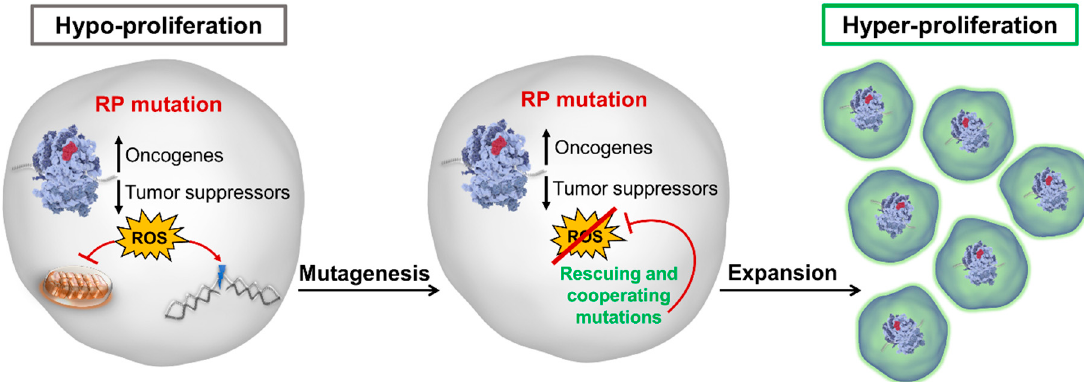
Figure 3. A model of the cellular transition from hypo- to hyperproliferation in ribosome-mutant diseases. Ribosomal defects alter the cellular translational landscape, promoting a protein expression profile that favors growth-promoting and disfavors tumor-suppressing factors. Defects in the assembly and/or function of ribosomes also leads to increased cellular stress and production of reactive oxygen species (ROS), which inhibits cellular proliferation and promotes DNA damage and higher mutagenesis. Over time, rescuing mutations arise that inhibit ROS production, thereby removing the block on cellular proliferation. This unleashes the cellular oncogenic potential, marking the beginning of the affected cell’s progression to transformation. RP: ribosomal